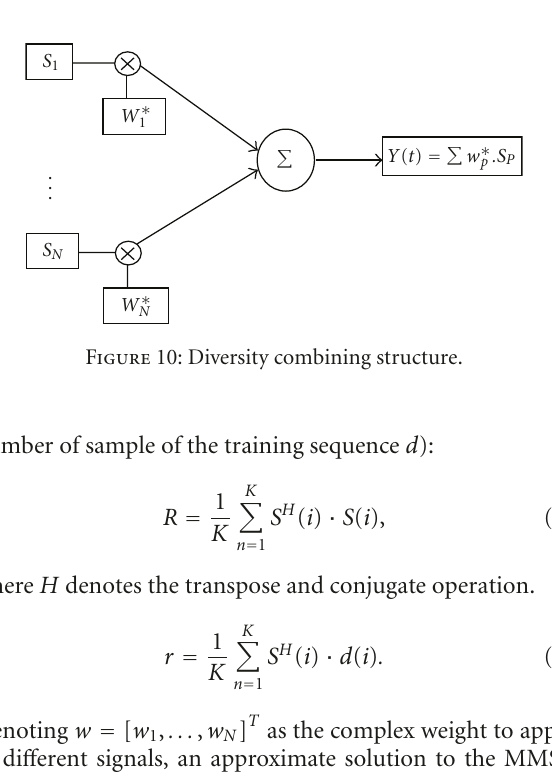
Figure 9: Example of received 40 MHz signal on one antenna and obtained signals after channel filtering.